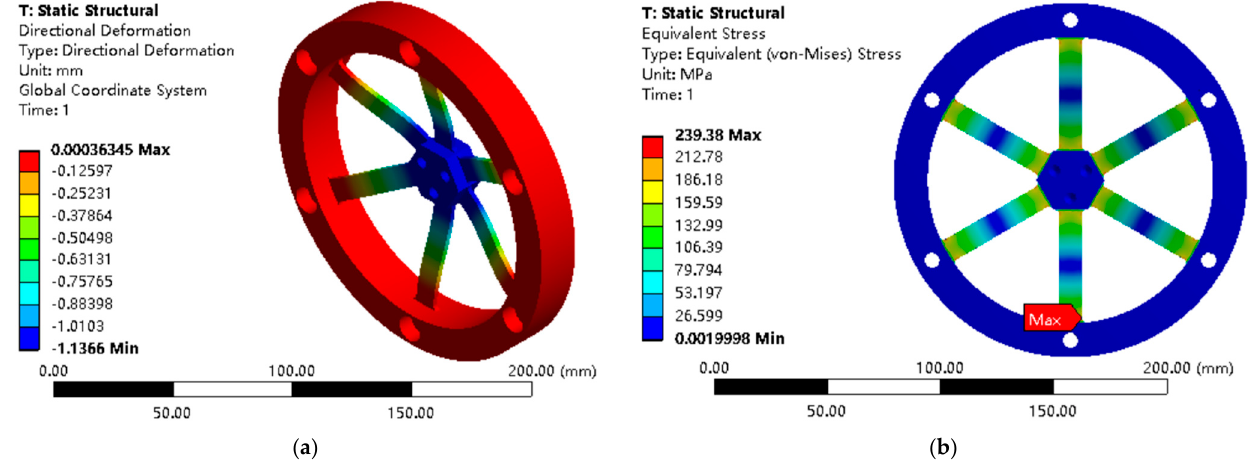
Figure 4. FEA results of the CEE for robotic polishing: ( a ) deformation; ( b ) stress distribution.